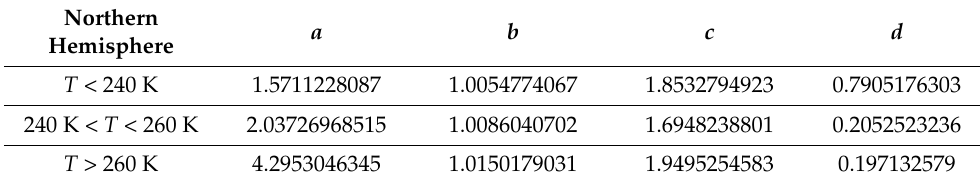
Table 2. Coefficients determined by multiple linear regression between MODIS brightness tempera- ture and the estimated surface temperature in the northern hemisphere